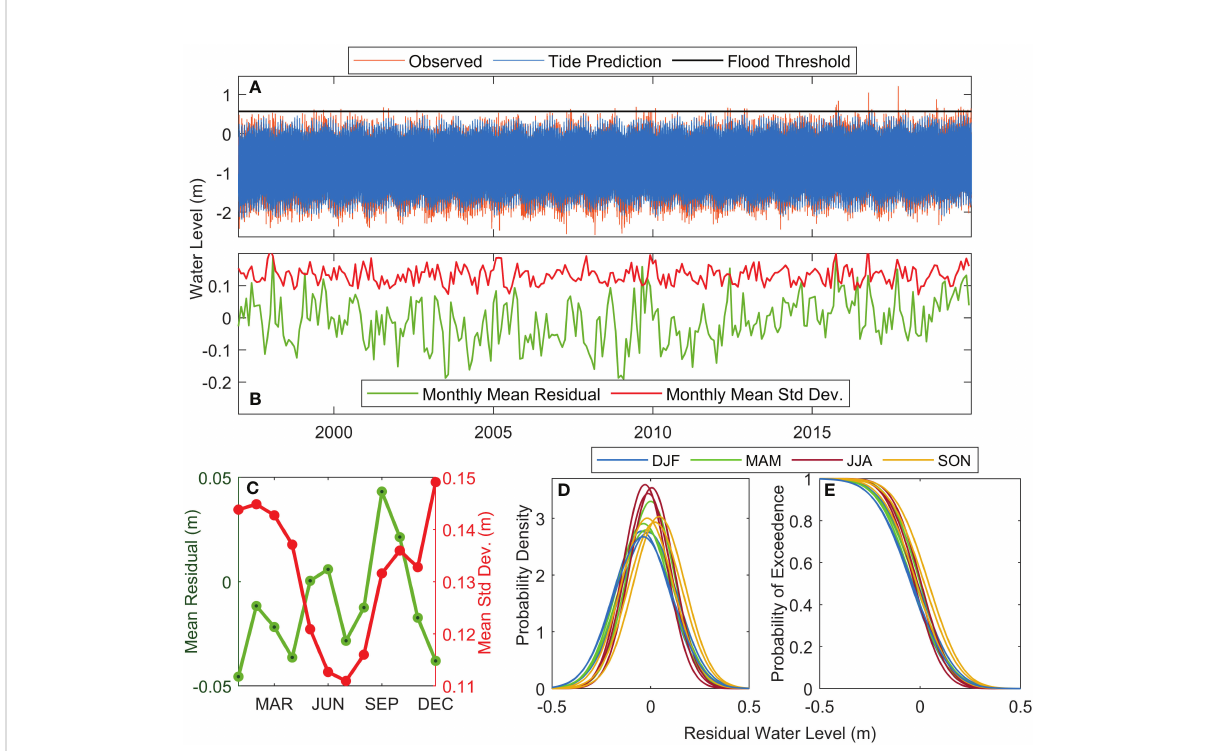
FIGURE 2 An example of the data preparation steps for Charleston, SC. The hourly observed water level (orange), SLR adjusted tide predictions (blue) and minor fl ood threshold (black line) relative to MHHW are shown (A) . Plot (B) shows the monthly non-tidal residual µ (mean of hourly residuals; green) and s (standard deviation of hourly residuals; red). Plot (C) shows the monthly average or climatological µ clim (green) and s clim (red), and plots (D, E) show the probability density functions and cumulative distribution functions given those µ and s for each month colored by